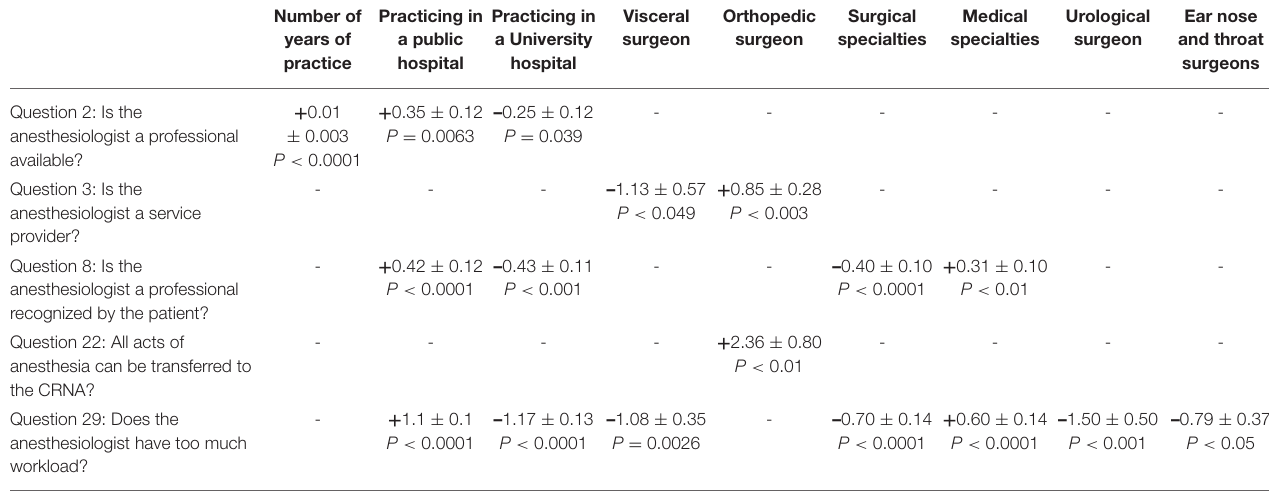
TABLE 3 | Multivariate analysis with associated factors positively or negatively influencing the change in mean evaluation for the Med group.